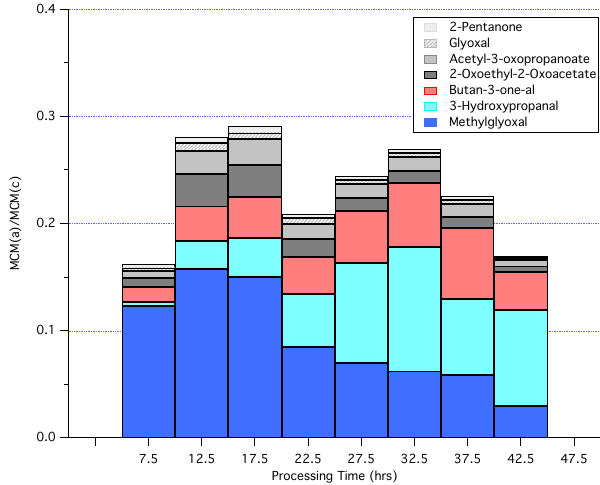
Fig. 15. 4-Term polynomial fits for various ratios as a function of processing time. The blue profile is the fit of the bin median (mea- surement/box model) ratio shown in Fig. 14 versus the butane time. The remaining profiles (black, green, red, light blue, and gray) are fits for the ratio of the Master Chemical Mechanism (MCM) using the complete chemistry of run a relative to MCM runs using vari- ous inputs versus processing time. In the MCM(a) run, all species in Table A3 were used to initialize the model and all species were allowed to build up and react. In the MCM(b) the model was initial- ized only using the values of species #1 in Table A3 but all species in the model were allowed to build up and react. In MCM(c) run the model was again only initialized using the values of species #1 in Table A3 but species #2 and #3 in this table were constrained to 0 throughout the model run (i.e. these species were not allowed to build up and react). The red MCM(a)/MCM(ss) profile was calcu- lated using all the species in Table A3 by applying the steady-state assumption in the denominator. The black profile, which represents the net sum of three contributions, the effects of non-steady-state, the effects of not initializing the model with species #2 and #3, and the effects of not allowing these additional species and their daugh- ter products to build up, is the sum of the green and red profiles. The gray profile shows the effects of incomplete model initialization, while the light blue profile was calculated by taking the difference of the green and gray profiles and depicts the impact of not allowing species #2 & #3, and hence their daughter products to build up.